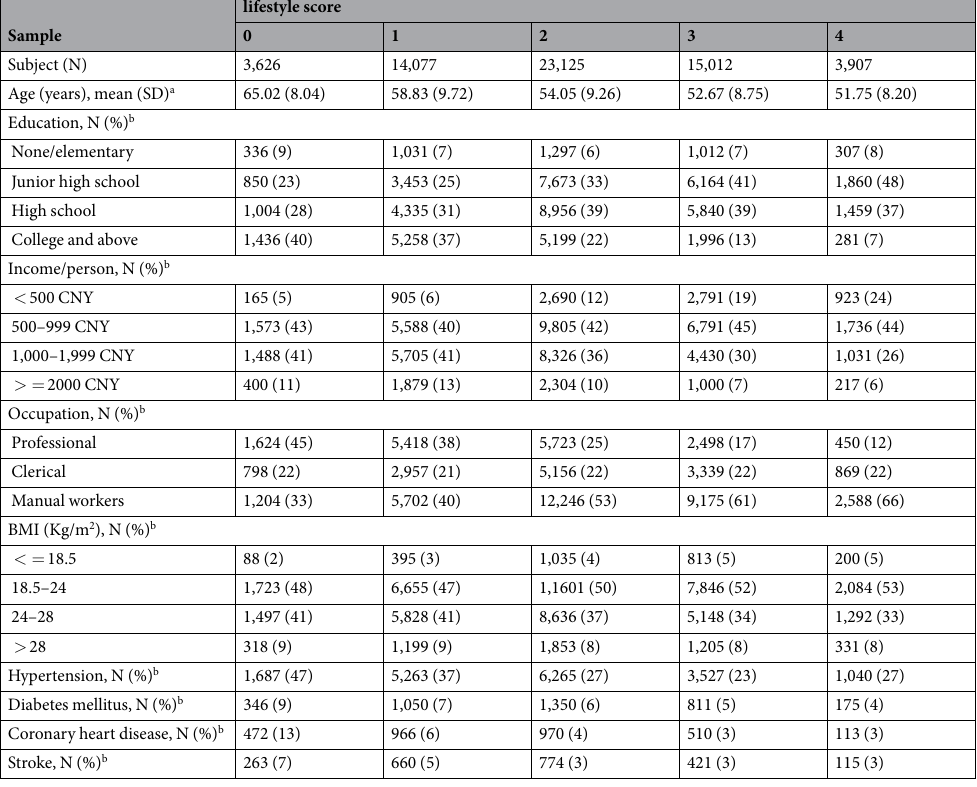
Table 2. Baseline characteristics of men by lifestyle risk index, the Shanghai Men’s Health Study (2002–2013, n = 59,747). N: number; SD: standard deviation; a: p-value from ANOVA test; b: p-value from Chi-square test; CNY: China Yuan; BMI: Body mass index, the cut-offs were defined according to the guideline of working group on obesity in China. All P values across all lifeatyle factors < 0.001